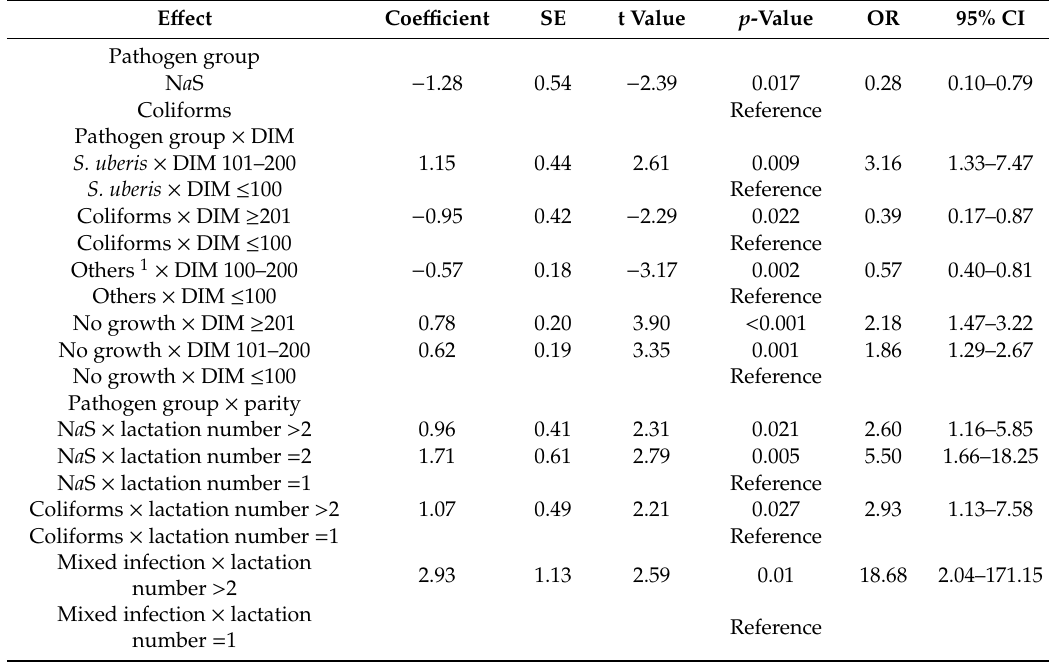
Table 7. Final mixed logistic regression model for cytological cure of clinical mastitis from 12 di ff erent herds in Northern